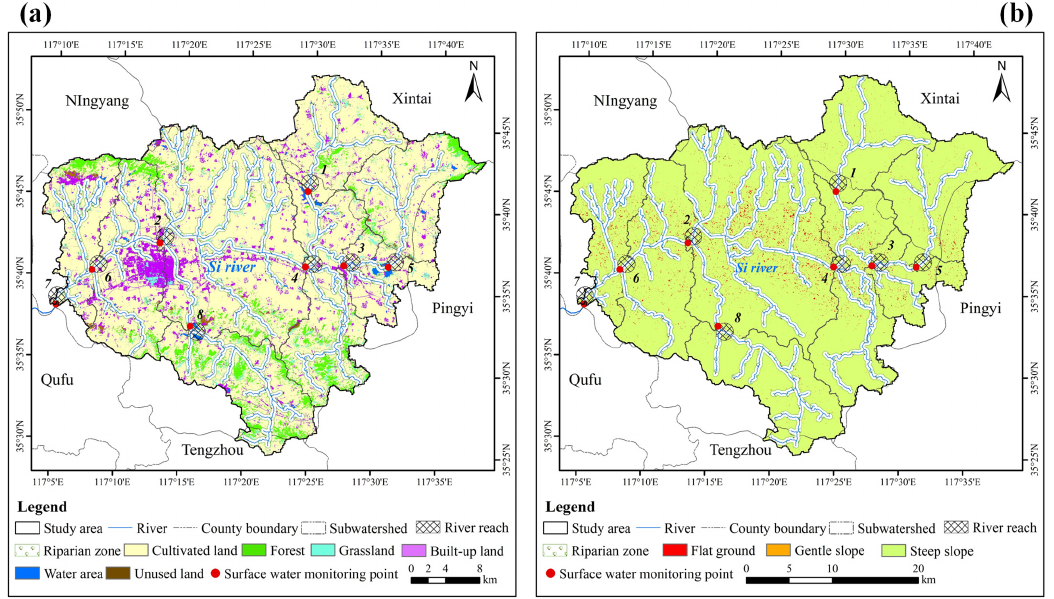
Figure 2. ( a ) Landscape types in three spatial scales; ( b ) Overview map of three spatial scales and three slope scales.